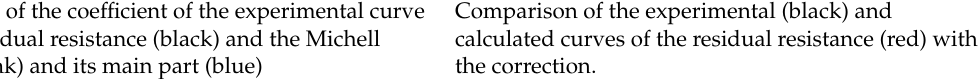
The curve of the coe ffi cient of the experimental curve of the residual resistance (black) and the Michell curve (pink) and its main part (blue)